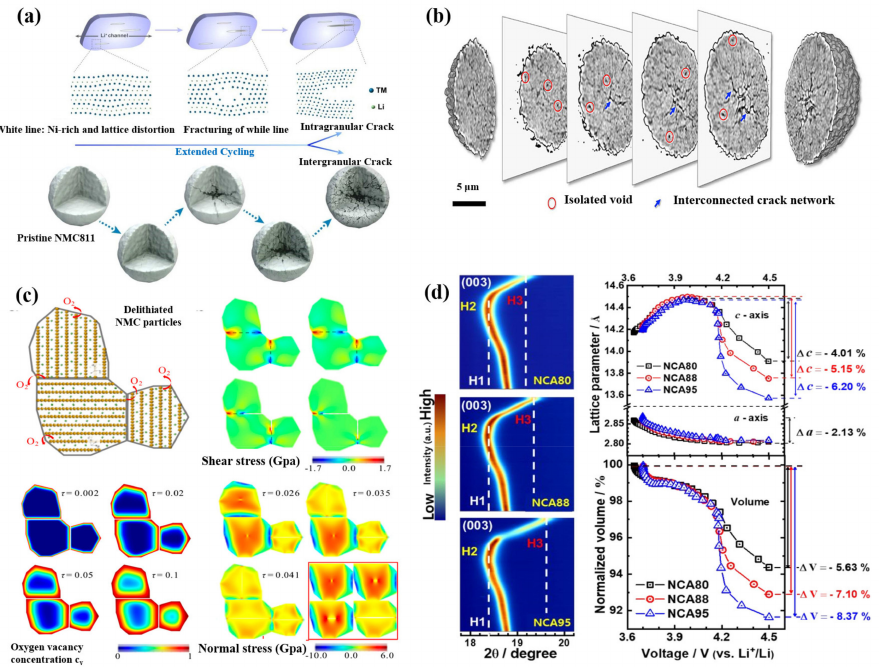
Figure 5. ( a ) Microstructure characteristics of intragranular and intergranular cracks.